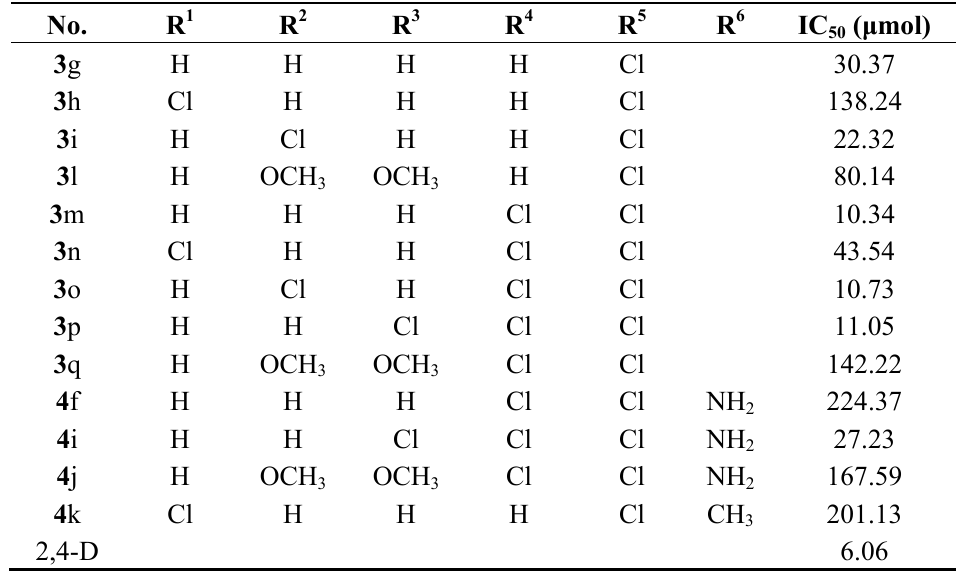
Table 3. IC values for the root elongation inhibition of rape for selected compounds from 3 and 4 . 50